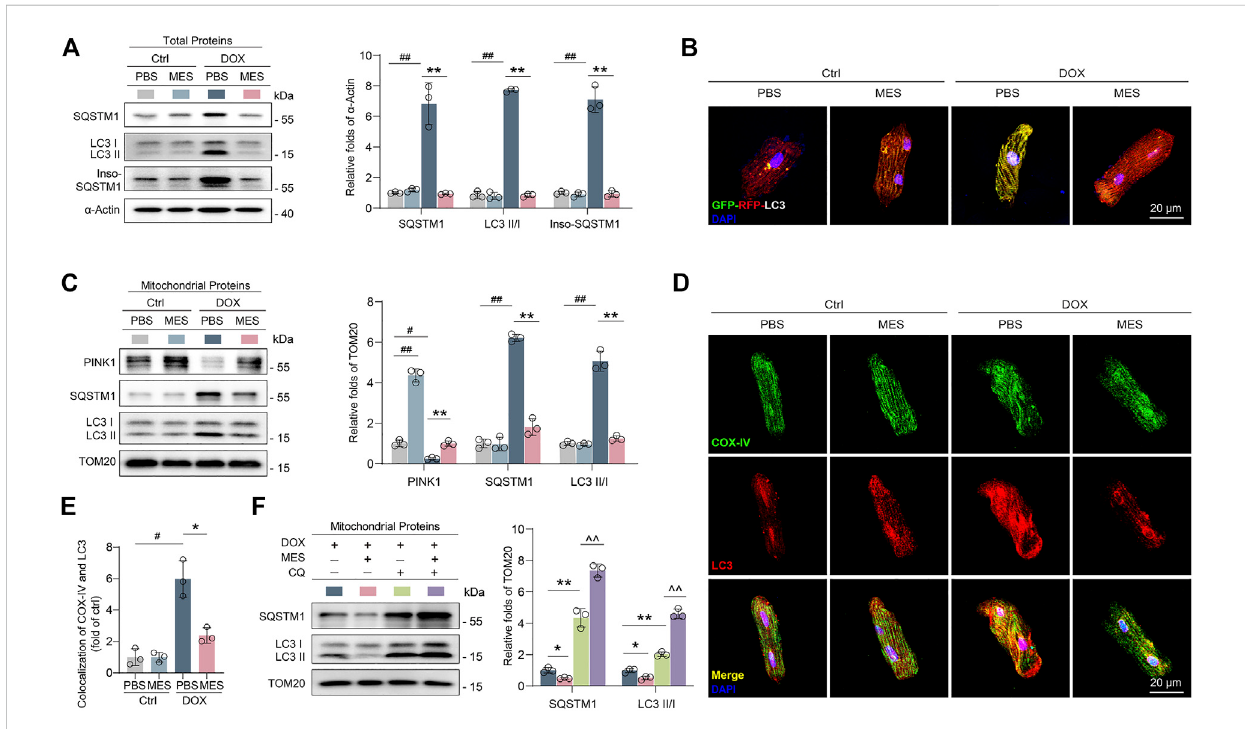
FIGURE 4 Mesaconine alleviated DOX-induced mitochondrial damage through activating mitophagy. (A) Levels of SQSTM1, LC3-II/LC3-I and insoluble SQSTM1 (Inso-SQSTM1) in heart tissues were detected using western blotting (n ≥ 3). (B) Cardiomyocytes expressing RFP-GFP-LC3 were treated with DOX and/or mesaconine. Autophagic fl ux was detected with live-cell imaging microscopy. Representative images showing red-colored autolysosomes or red/green double-colored autophagosomes. (C) Levels of PINK1, SQSTM1, and LC3-II/LC3-I in isolated mitochondria form the cardiomyocytes of DOX and/or mesaconine treated mice. (D, E) Primary cardiomyocytes were immunostained with an anti-COX-IV Ab and an anti-LC3 Ab to detect the colocalization of autophagosomes with mitochondria. (F) Mesaconine-induced restoring of autophagic fl ux could be turnovered by CQ treatment in mitochondria isolated from the cardiomyocytes of DOX-treated mice. Representative immunoblots and the ratio of the indicated protein to TOM20 are presented. Data are represented as means ± SEM of 3 biologically independent replicates assays. *, # p < 0.05; **, ##, ^^ p <